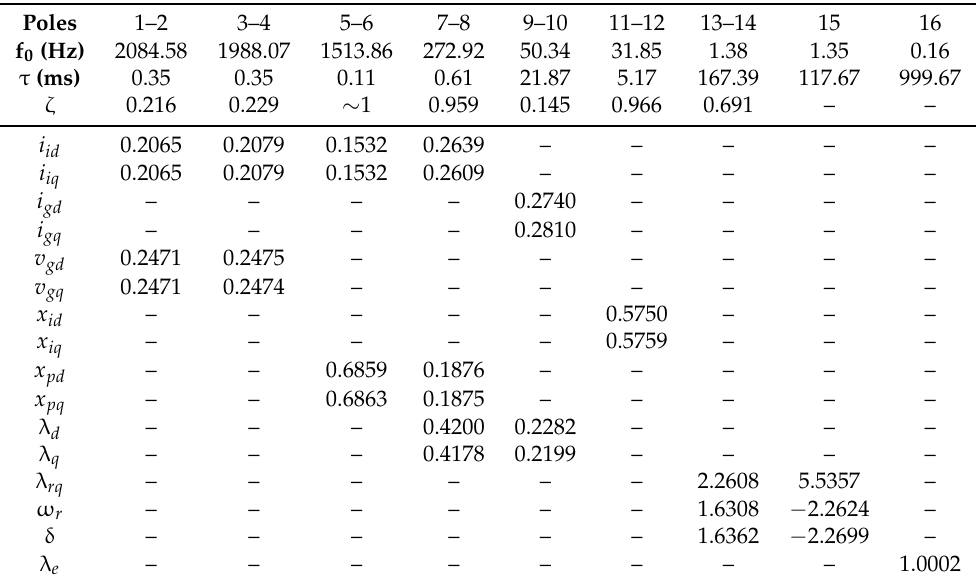
Figure 8. Pole map of the S-SVC. The poles are numbered according to Table 1. Table 1. Poles and participation factors. Only significant factors are displayed (larger than 0.1).